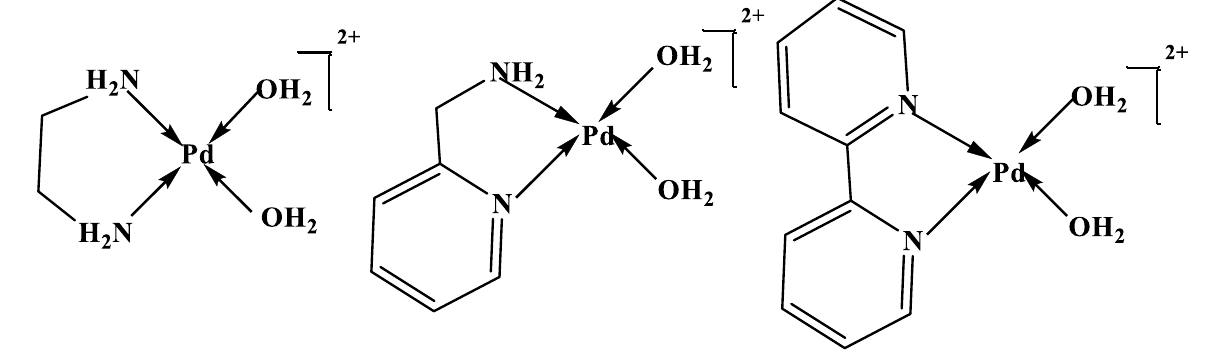
Figure 1. Structure of some Pd(II) diaqua complexes.